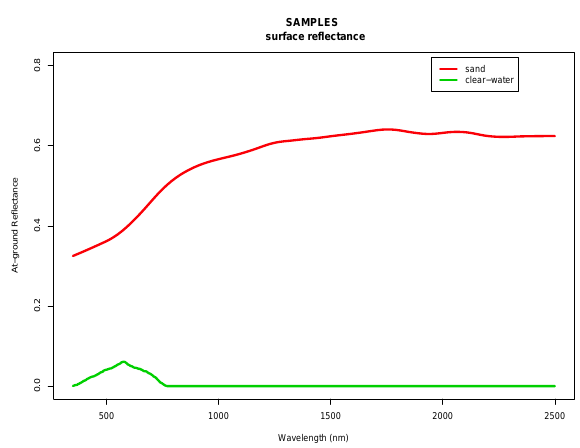
Fig. 2. Surface reflectance, ρ gnd (λ) contained in the 6SV1.1 source code: sand for bright and water for dark in the spectral domain: 400– 2500nm sampled at 2.5nm.